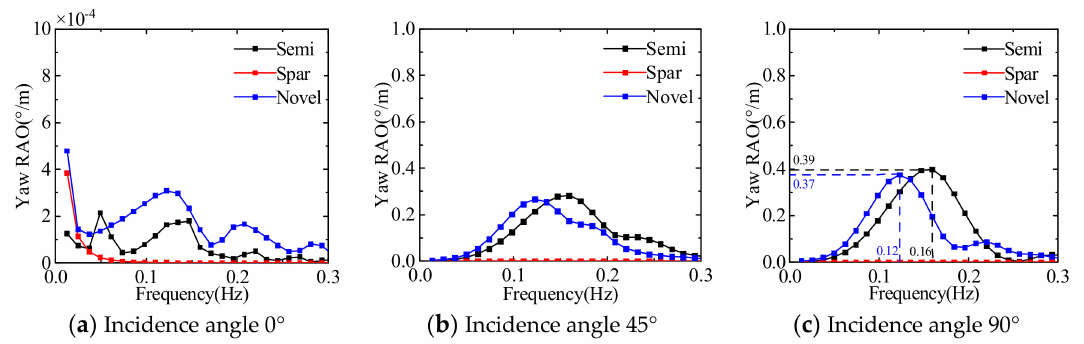
Figure 24. Comparison of the response amplitude operator in pitch direction of three floating platforms.